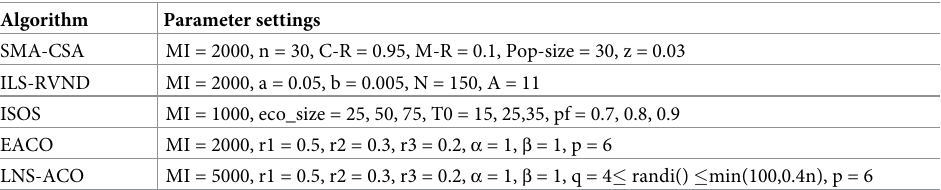
Table 12. Algorithms-specific parameter